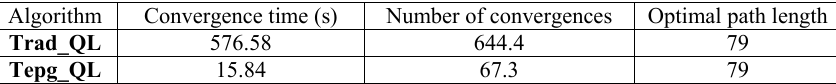
Table 1. Performance comparison of two